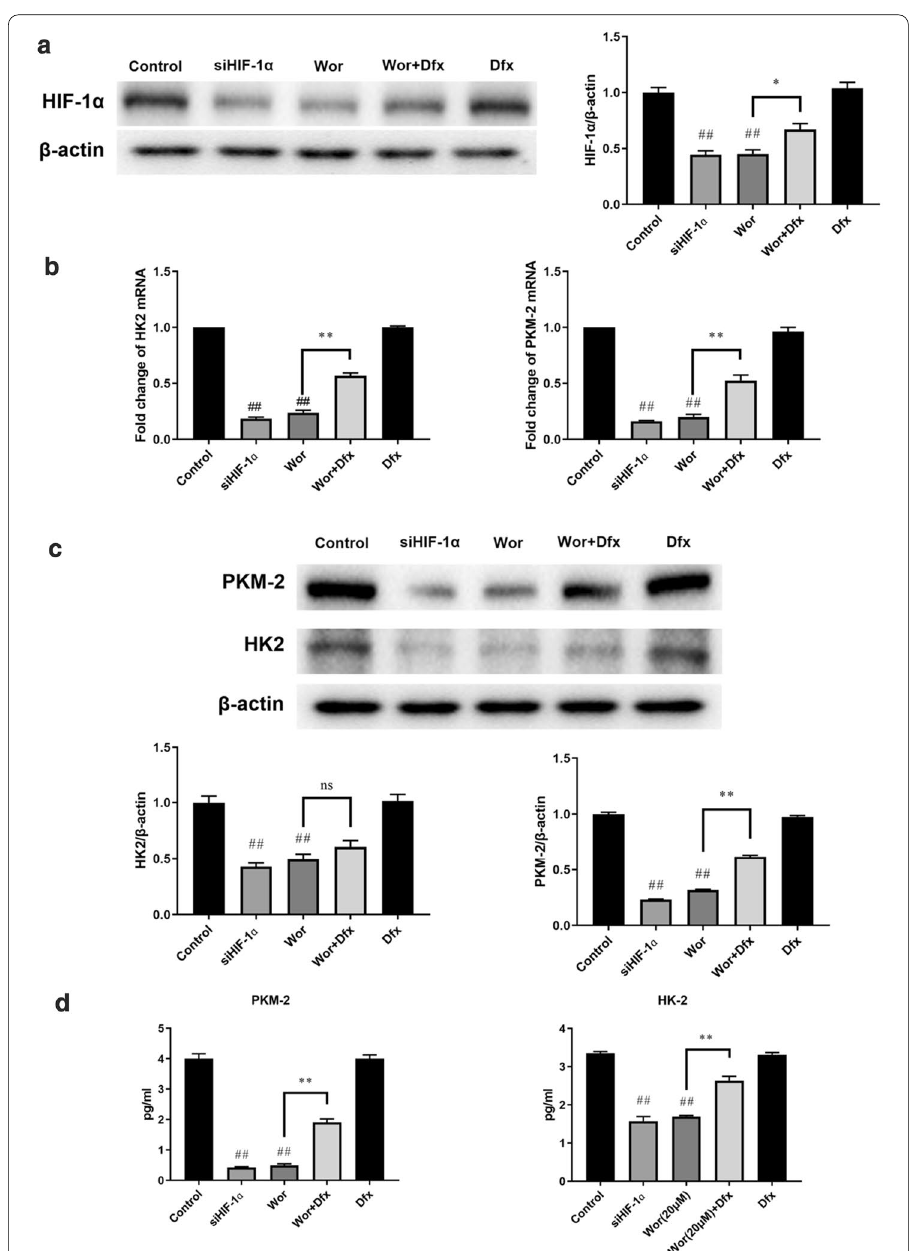
Fig. 5 Worenine inhibits HIF-1α and further blocks HK-2 and PKM2 expression. HCT116 cells were treated with worenine (Wor; 20 μM), desferrioxamine (Dfx; 30 μM), siRNA of HIF-1α (siHIF-1α), and worenine combined with desferrioxamine (Wor Dfx) for 24 h. DMSO-treated cells were used as a control. a The + protein expression of HIF-1α was assayed via western blotting. b The mRNA expressions of PKM-2 and HK2 were determined using real-time PCR. c GLUT3, HK2, PKM2 and LDHA protein expressions were determined using western blotting. d The concentrations of HK-2 and PKM2 were determined using ELISA. The data are the means SEM. ## p < 0.01 vs. control group. *p < 0.05 and **p < 0.01 vs. worenine ± With the stabilization of HIF-1α by Dfx, the decrease in HK-2 and PKM2 expression induced by worenine treatment was reversed. In addition, Dfx (30 μM) alone did not affect HIF-1α, HK-2 and PKM2 expression.